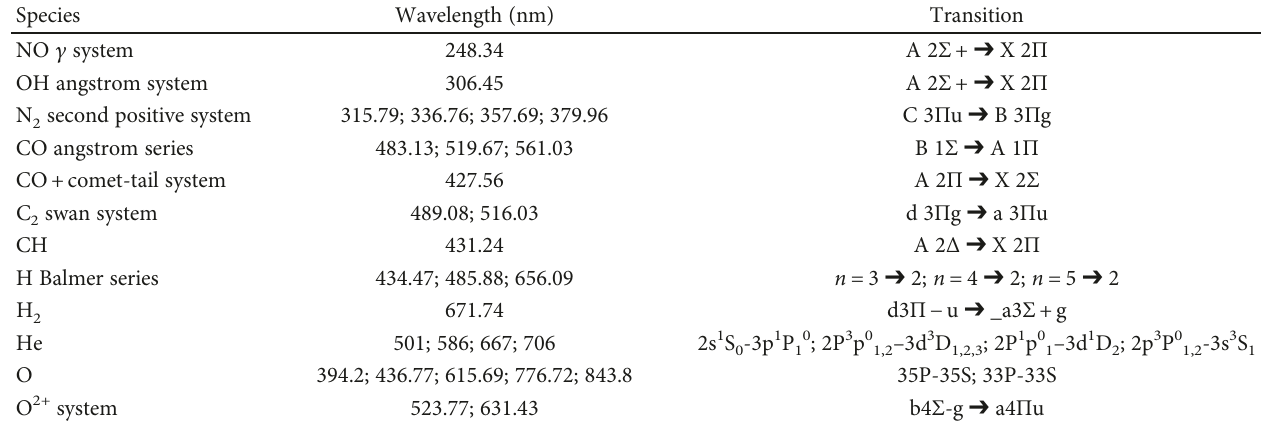
Table 2: Emissive species generated into plasma region evaluated by optical emission